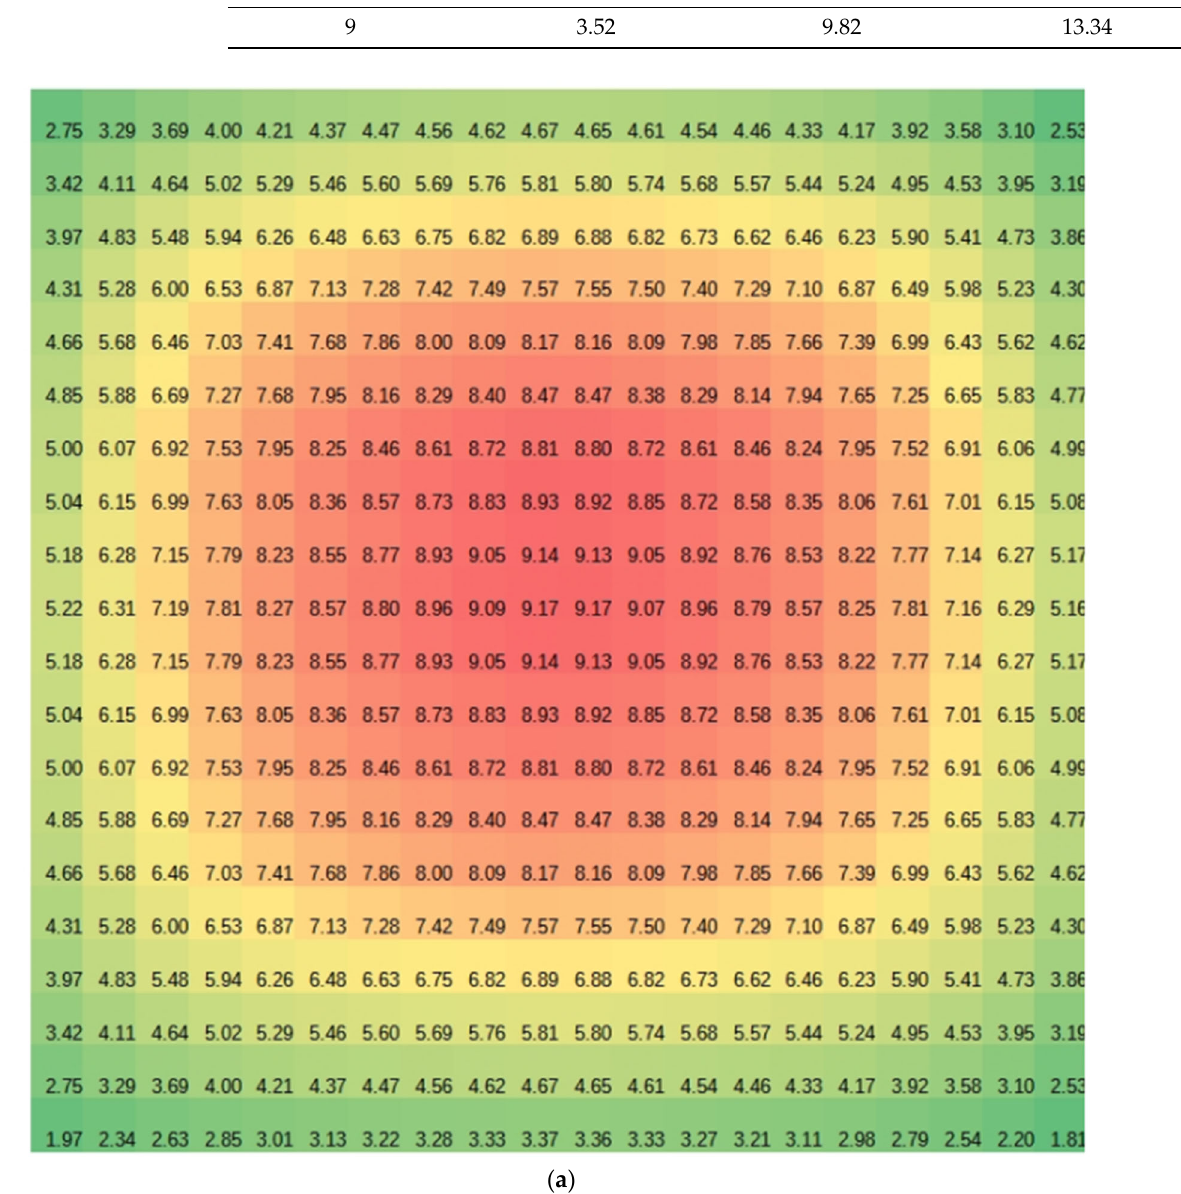
respectively, using the Z values given in Table 1 and assuming a residence time of 0.08 s, which was calculated by taking the length of the chamber divided by the bulk velocity.